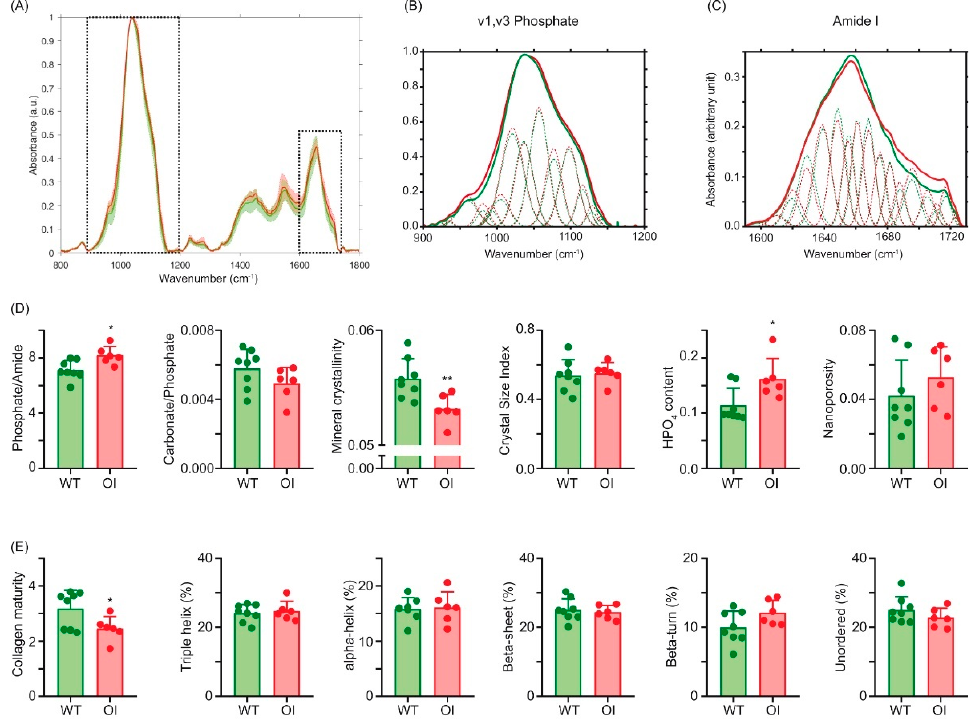
Figure 6. Bone tissue material properties at the femur. ( A ) Mean spectrum in WT mice (green line) and oim (red line). ( B ) Inset of the spectrum in the v1, v3 PO4 band with position, width and intensity of subpeaks determined by second-derivative and curve-fitting spectroscopy. ( C ) Inset of the spectrum in the amide I band with position, width and intensity of subpeaks determined by second-derivative and curve-fitting spectroscopy. ( D ) Mineral and ( E ) organic bone tissue material properties. n = 10 and n = 6 for WT mice and oim, respectively *: p < 0.05; **: p < 0.01.